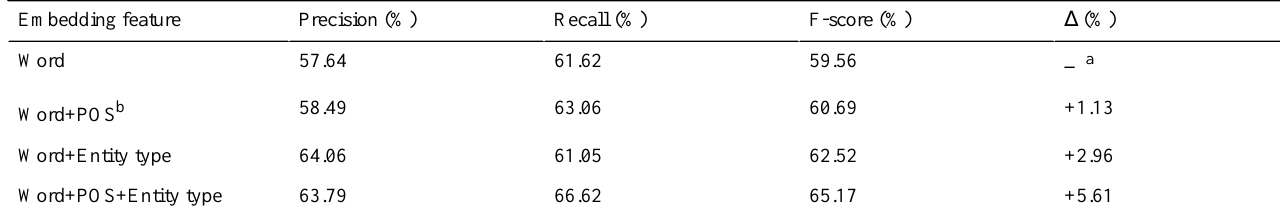
Table 4. Performance evaluation of different embedding features.